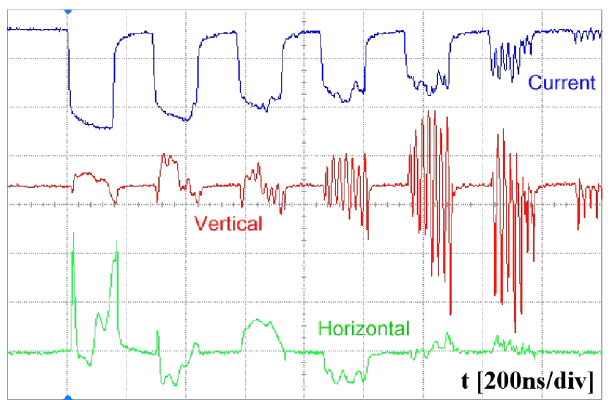
FIG. 3. Scope traces from a ring BPM showing the CR vertical instability. The plot shows, from top to bottom, the circulating beam current in the case of 400 bunches and the vertical and horizontal signals. The vertical scale for the current signal is (cid:6) 2 A = division , the vertical scale for the vertical signal is (cid:6) 4 mm = division , and for the horizontal one is (cid:6) 2 mm = division .